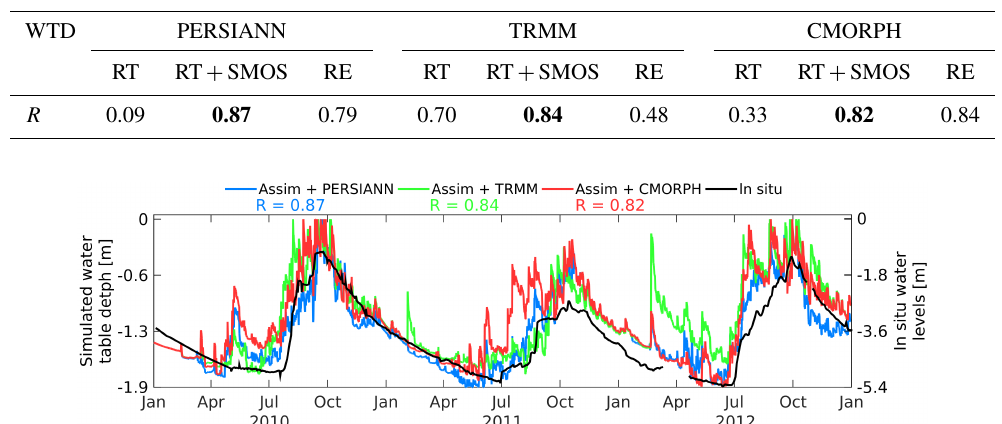
Table 3. Statistics of the simulated water table depth (WTD) compared to the in situ measurements at the Nalohou station for 2010–2012. Three cases are considered: open-loop simulations using real-time satellite precipitation (RT), assimilation of SMOS soil moisture with real-time precipitation (RT + SMOS), and open-loop simulation using reanalyzed precipitation (RE). Since the simulations and the in situ measurements are not directly comparable, only the correlation ( R ) is shown here. Improvement of the correlation is indicated in bold font.